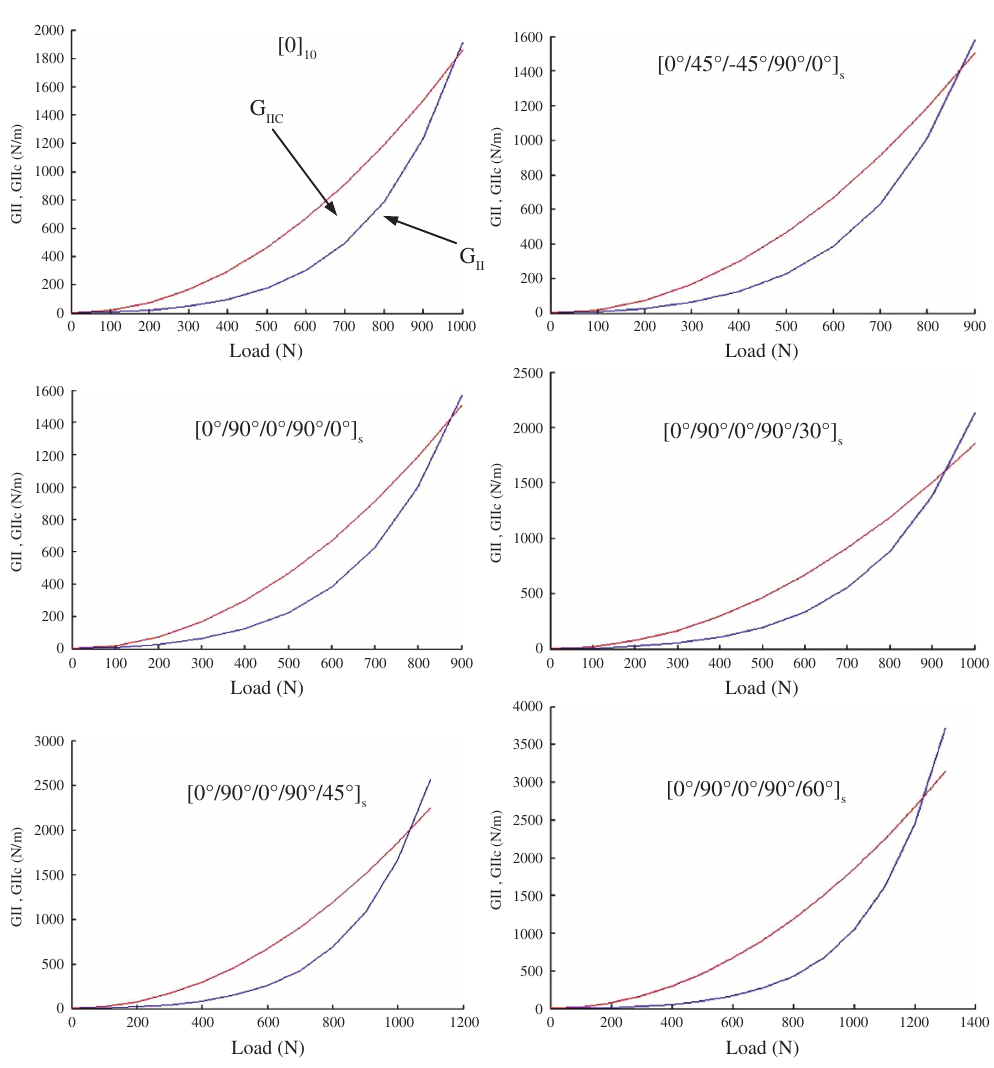
Figure 4 Energy release rate-load diagram for s-glass/epoxy obtained from meshfree